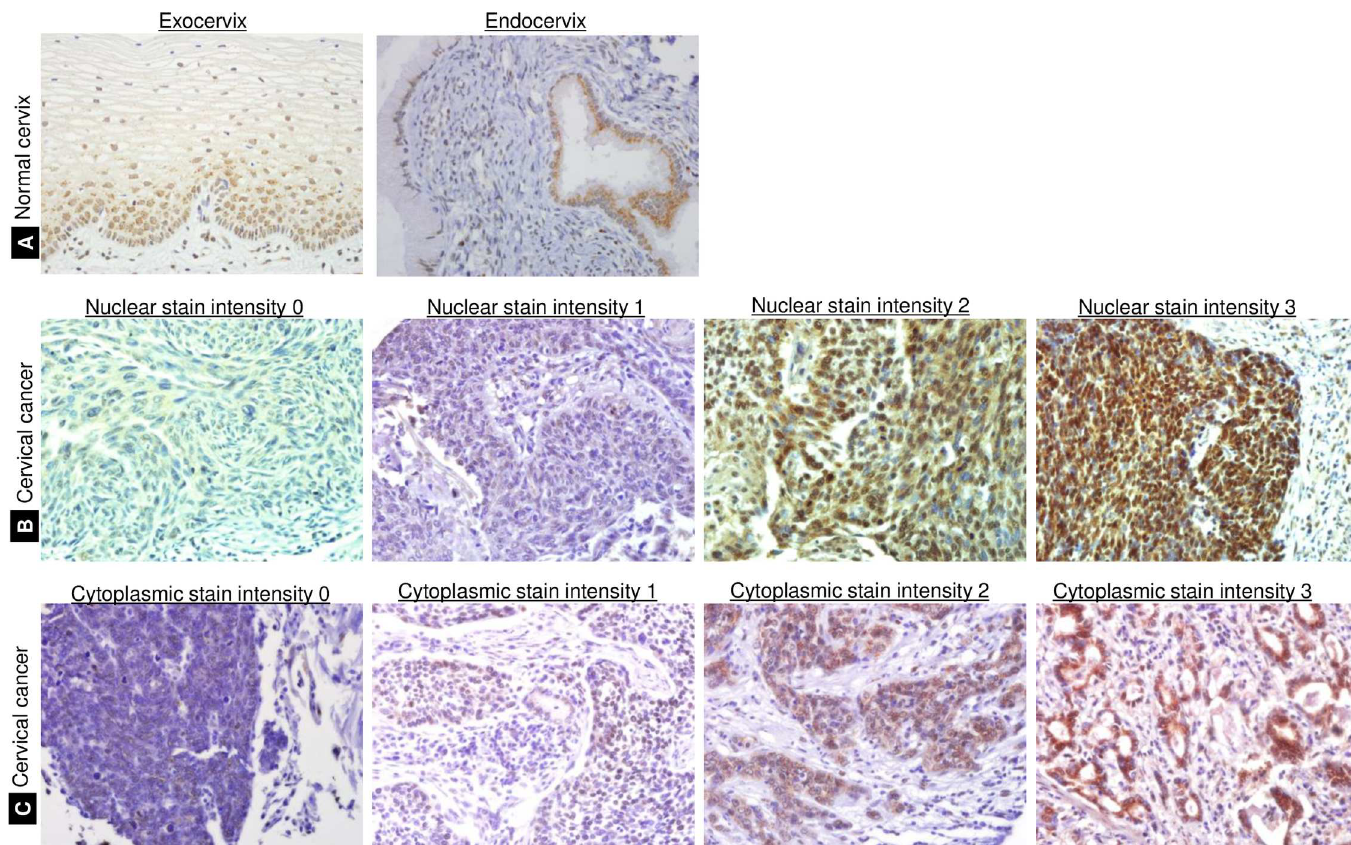
Fig 1. GS28 immunohistochemicalstainingin the cervix. (A) In normalcervicaltissues, GS28 immunostaining is distributedin the cytoplasmic and nuclear compartments of exocervicalsquamouscells and endocervical glandularcells. The stainingintensityvaries, but it is mostlyweak. (B) In cervical cancer tissues, the stainingintensityof GS28 varies widely fromno staining(score0) or weak staining(score1) to moderateor strongstaining(scores2 and 3), in the nuclear compartment.(C) GS28 expression is also seen in the cytoplasmiccompartments of cervicalcancer tissues with varyingintensities,from scores 0 to